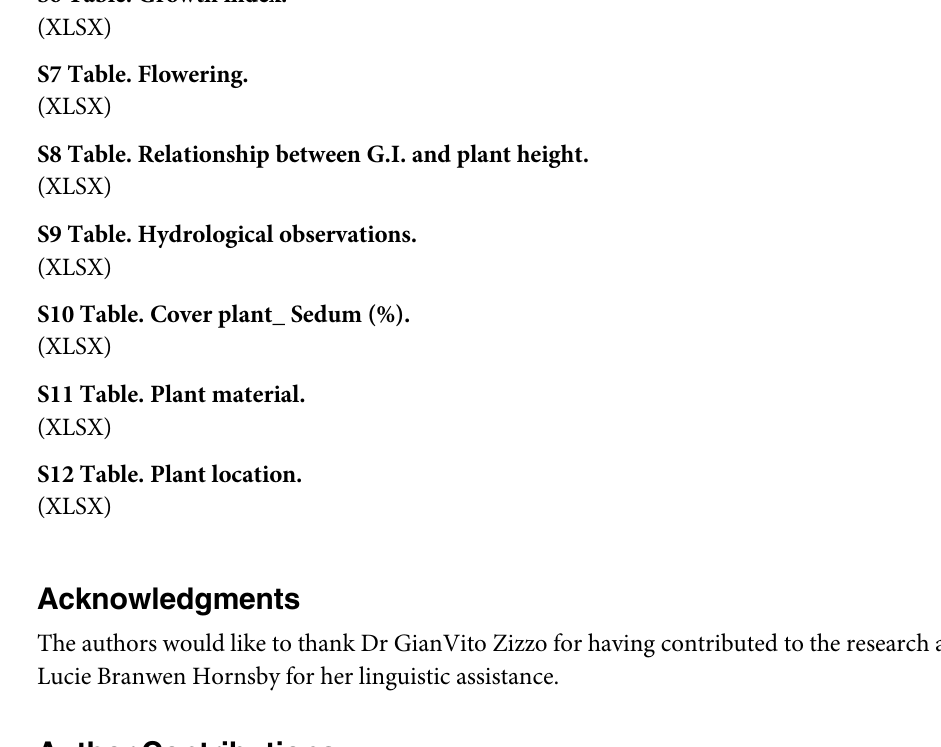
S6 Table. Growth index. S7 Table. Flowering. S8 Table. Relationship between G.I. and plant height. S9 Table. Hydrological observations. S10 Table. Cover plant_ Sedum (%). S11 Table. Plant material. S12 Table. Plant